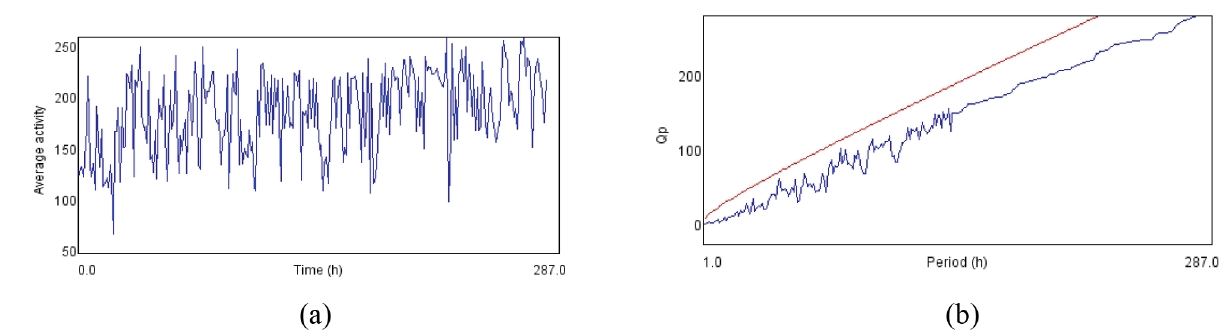
FIGURE 12S - (a) and (b) shows the average activity pattern and chi-square periodogram respectively for Control flies exposed to luteolin (100 µM).